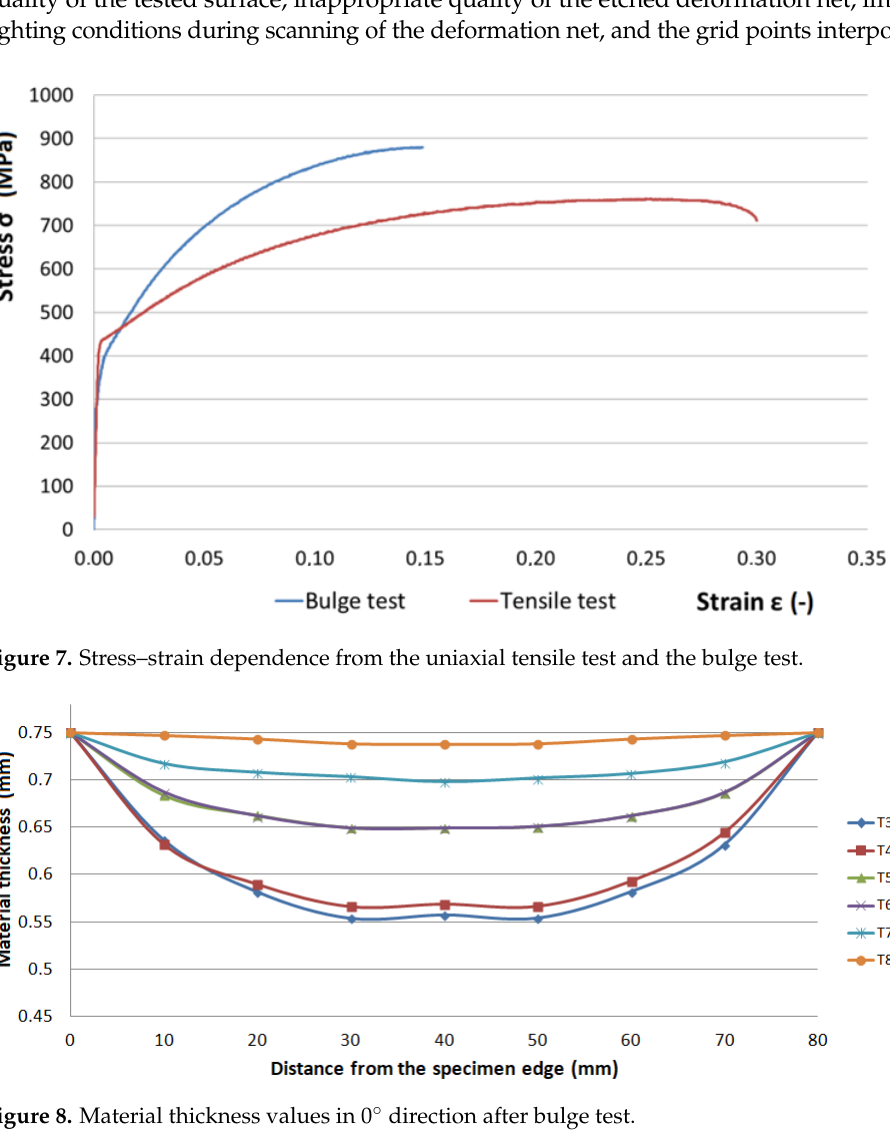
Figure 6. Stress – strain curves of TRIP steel for specimens T3 – T8.